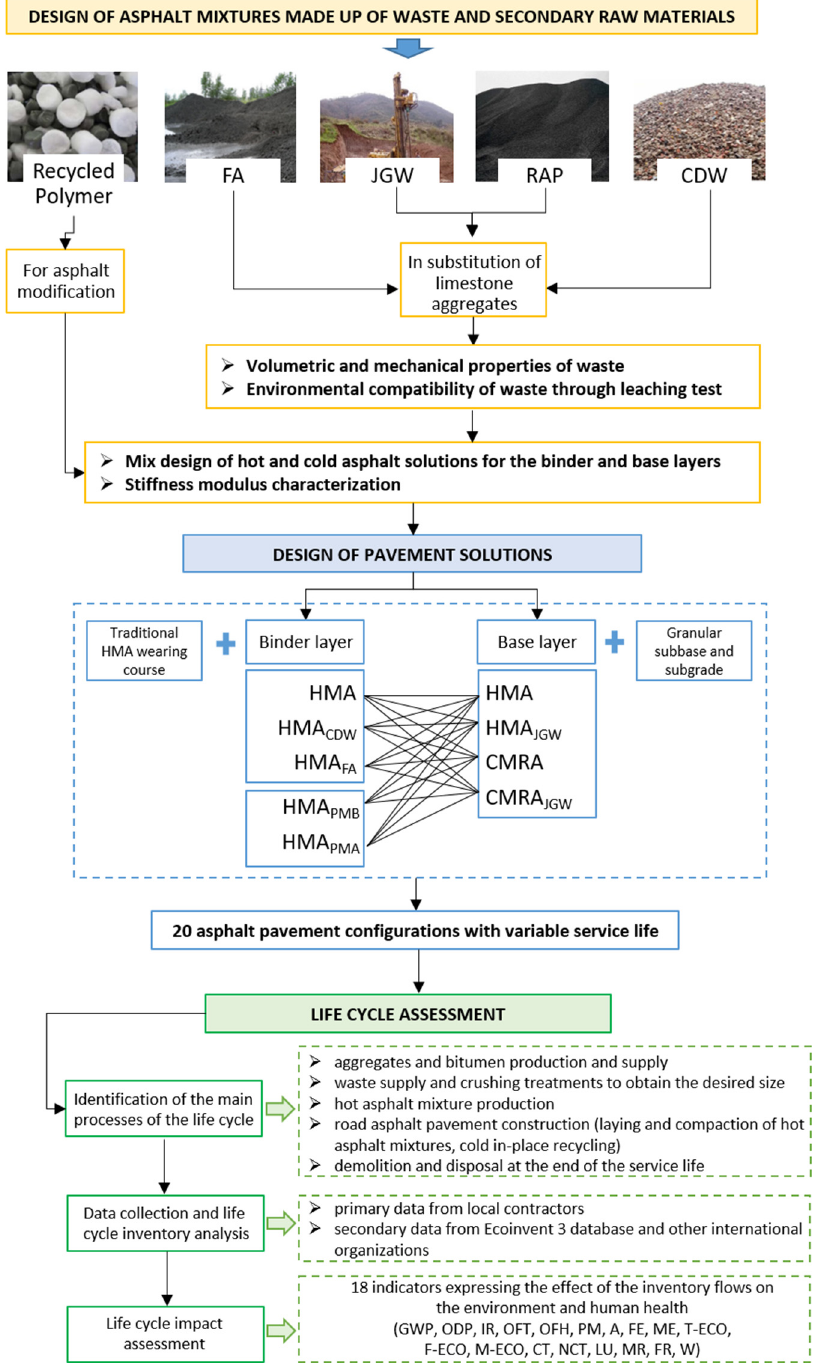
Figure 1. Workflow of the research.